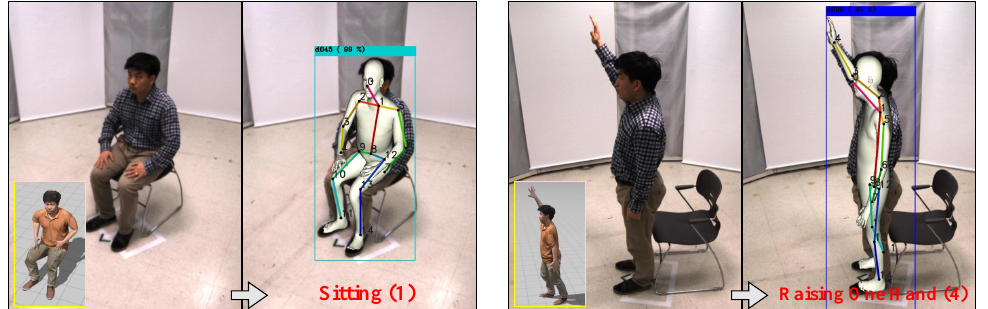
Figure 1. Examples of our view-specific action